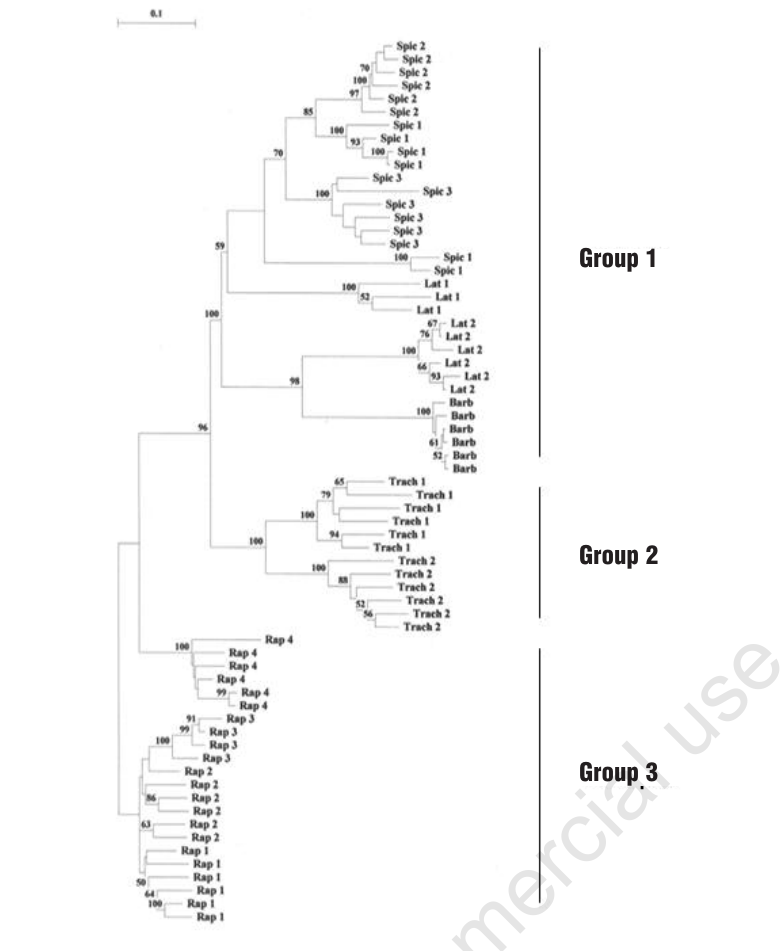
Figure 2. Consensus tree between Campanula populations and species for the presence/absence of the joined myb and NBS markers. Numbers at the internodes indi- cate bootstrap values from 1,000 re-sampling